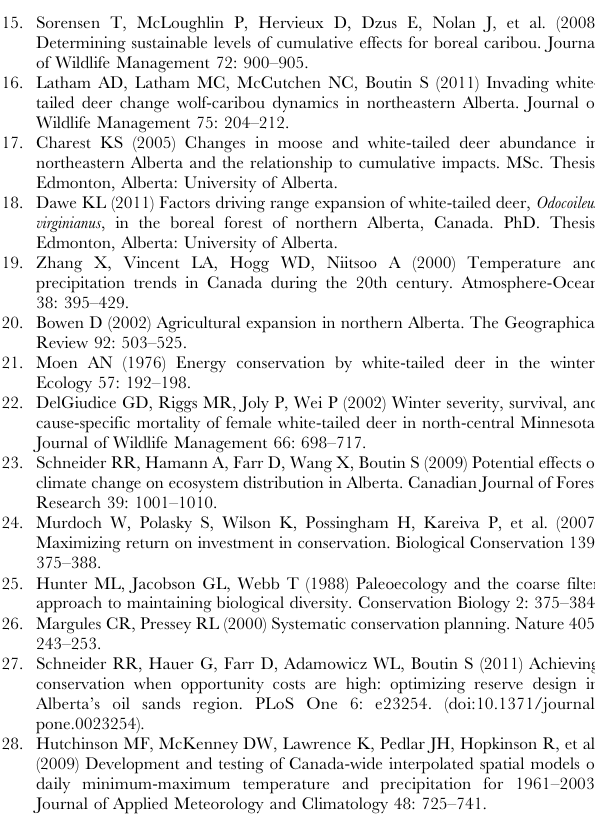
Figure S3 Projected distribution of parkland and grass- land bioclimatic zones in 2050. The map presents the overlaid projections for these two zones from three climate models. (TIF) Figure S4 Net present value of petroleum and forestry resources, by township. (TIF) Figure S5 The Natural Subregions of Alberta. Note that grassland and parkland subregions were largely excluded from the analysis because they contain little public land (see Fig. 1). Figure S6 Planning units used in the Marxan modeling. Private land is excluded from all designs (locked-out) and existing protected areas are included in all designs (locked-in).